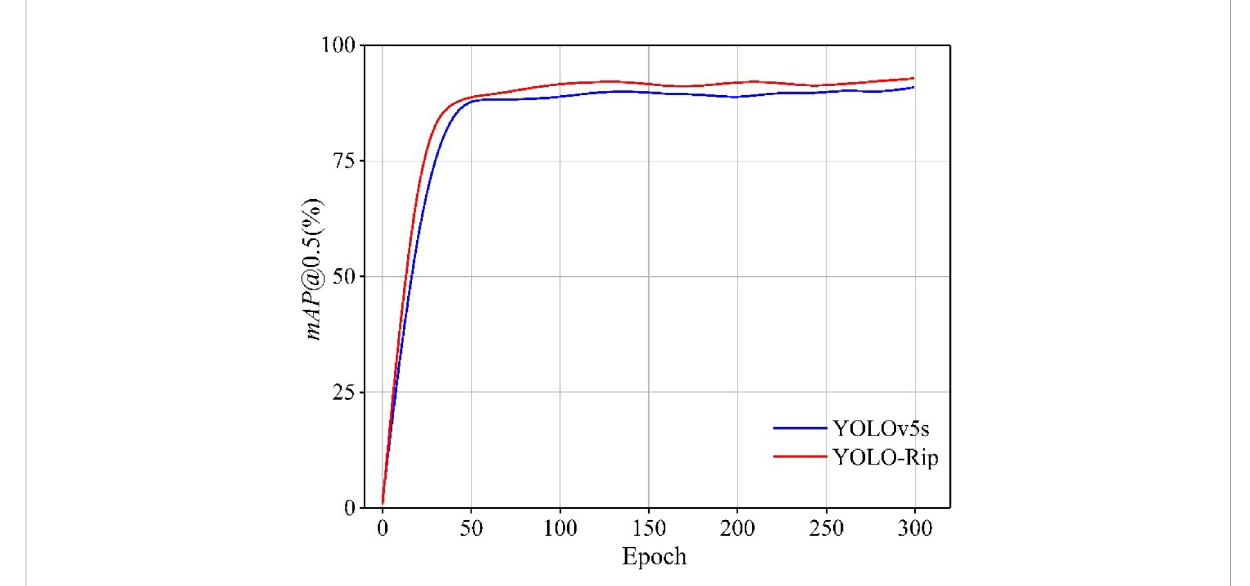
FIGURE 10 Comparison of mAP values between YOLOv5s and YOLO-Rip training datasets.